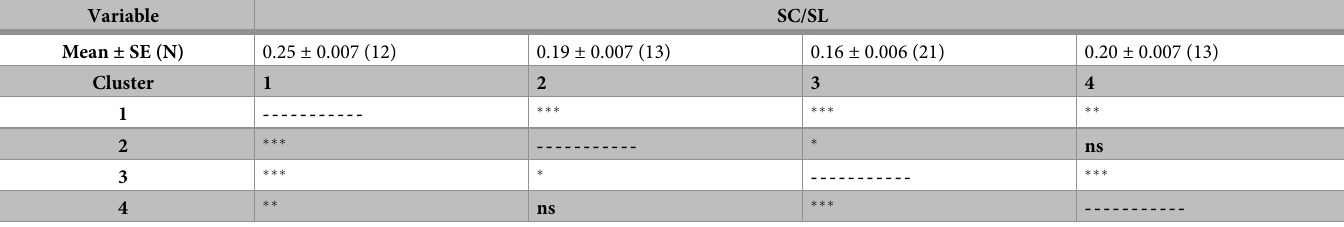
Abbreviations: N = sample size; ns = non-significant differences; SE = standard error.